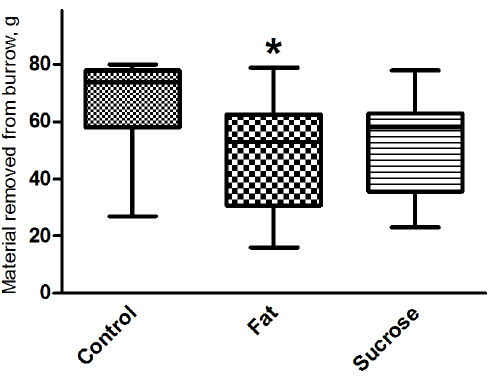
Figure 2. The Burrowing test. Mice on HF diet removed significantly less bedding material from the tube than mice on C diet (p=0.035). A tendency of reduced burrow-digging is seen for mice on HS diet (p=0.064). However, although not quantified, this diet group burrowed less goal-oriented, as observations showed excessive digging in the whole cage. Median with ranges.